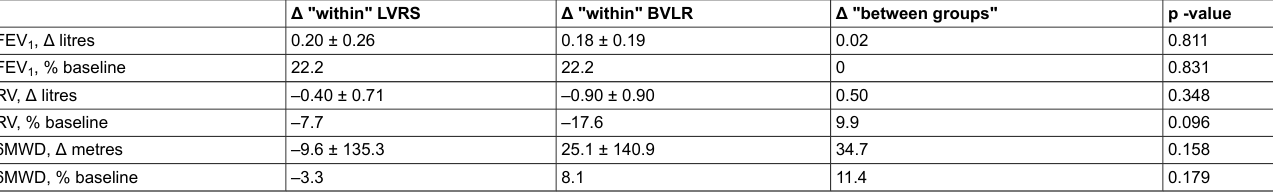
Table 4: Vertical (within group) and horizontal (between groups) comparison according to method of lung volume